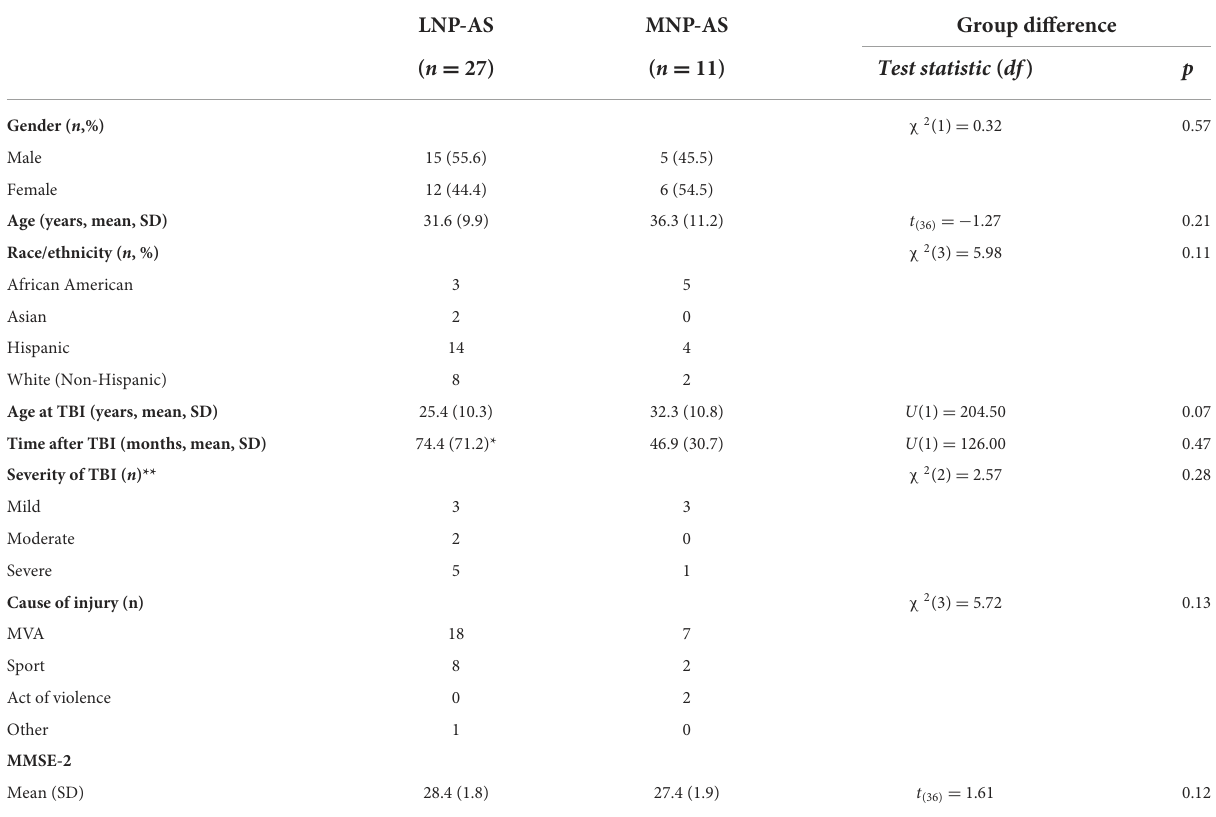
TABLE 1 Demographic and injury